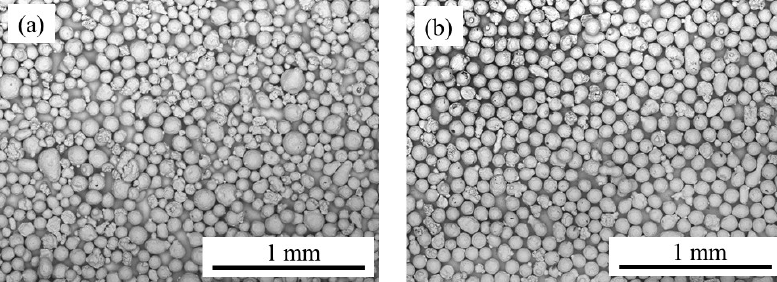
Figure 3. Scanning electron microscopy (SEM) images of Cu particle monolayer wicks: ( a ) sample #1 (as-received powder) and ( b ) sample #2 (sieved powder).